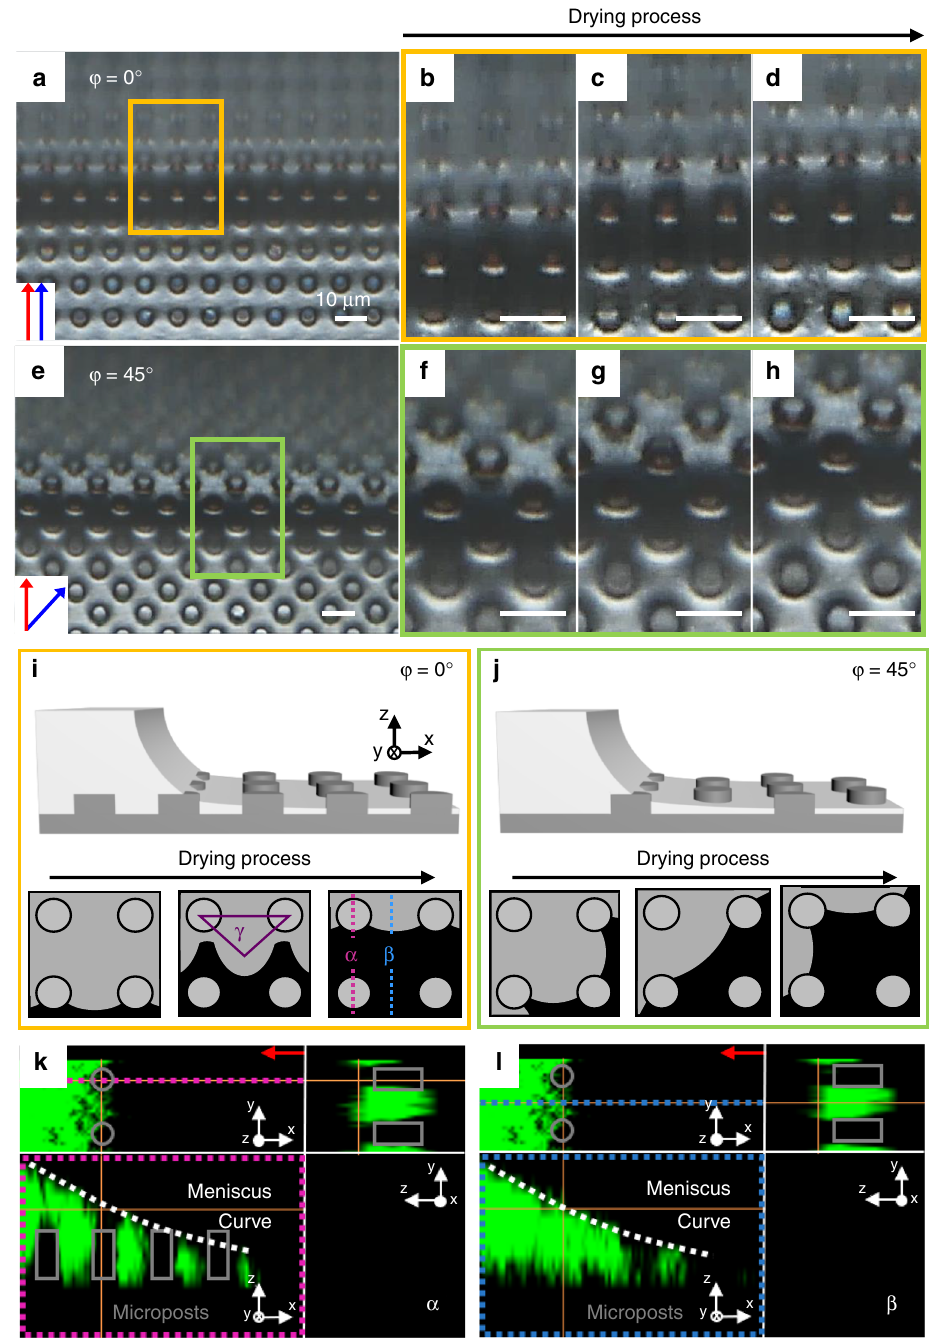
Fig. 3 The in situ contact line changes during the process. Darker images can be observed when the meniscus generates at a φ = 0° and e φ = 45° and enlarged images in the colour boxes show the detailed contact line behaviour b – d φ = 0° and f – h φ = 45°. The red arrow indicates the pulling direction. The drying process follows this direction, producing distinctive contact lines with varying φ . Schematic sketches as the DNA solution dries show how the contact lines were changed at i φ = 0° and j φ = 45°. k , l Fluorescent confocal microscopy images show the cross section view at the α and β regions. The grey blocks indicate microposts. All scales are 10 μ